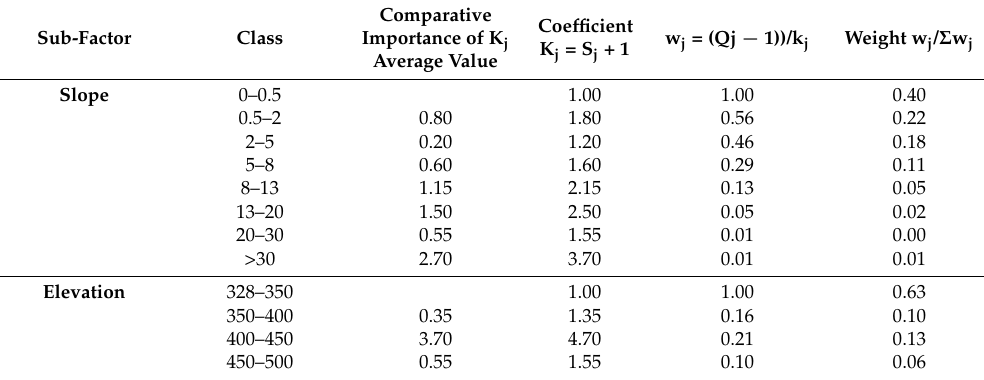
Table 1. Spatial relationship between flood-conditioning factors and flooding occurrences locations